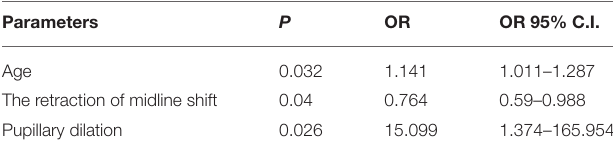
TABLE 2 | Binary logistic regression shows the independent factors of postoperative outcomes. Parameters